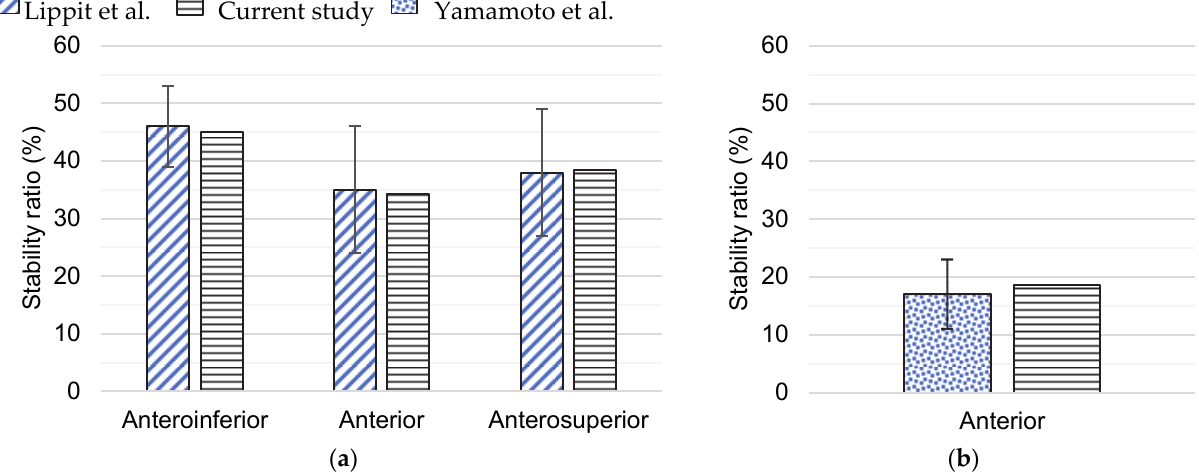
Figure 4. Stability ratios for ( a ) the healthy glenohumeral joint model and ( b ) the glenohumeral joint model with a 20% glenoid bone defect. For the sake of comparison, means and standard deviations of the experimental data of Lippit et al. [31] and Yamamoto et al. [17] are also presented.